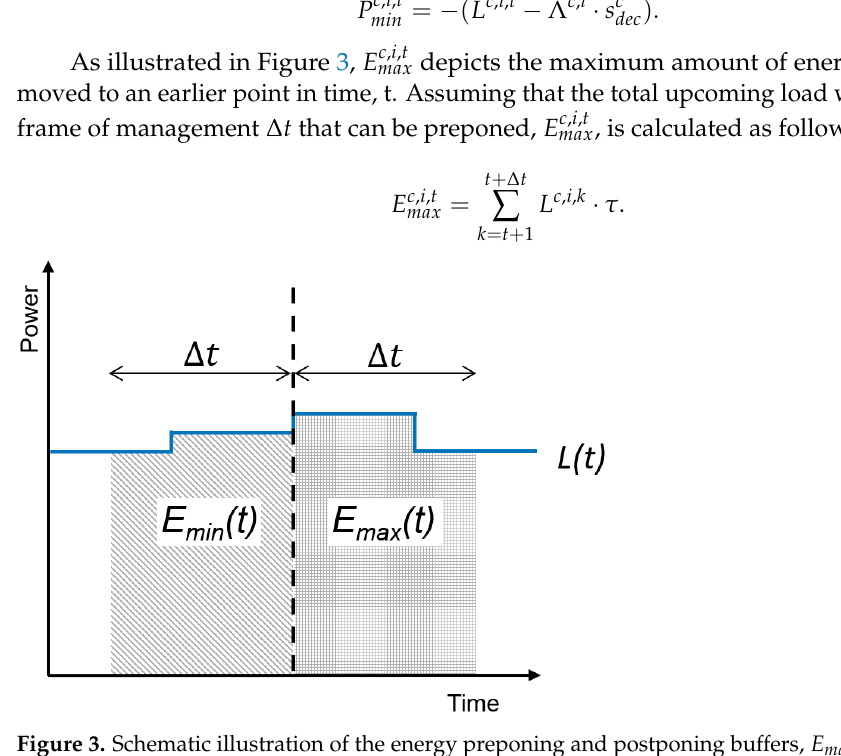
Figure 3. Schematic illustration of the energy preponing and postponing buffers, E max and E min